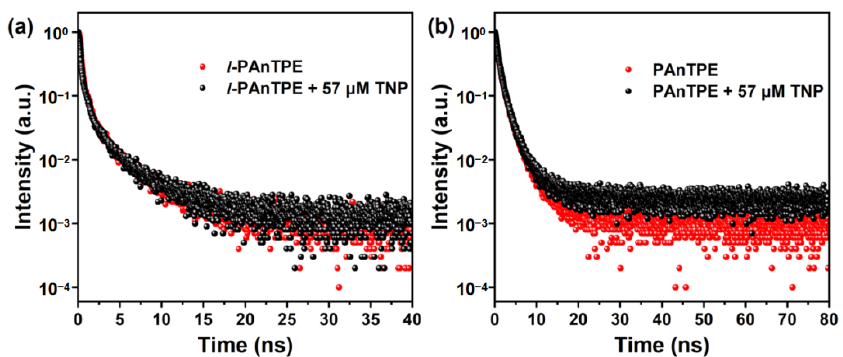
Figure 9. The lifetime decay curves of l -PAnTPE ( a ) and PAnTPE ( b ) in water before and after adding TNP (57 µM).